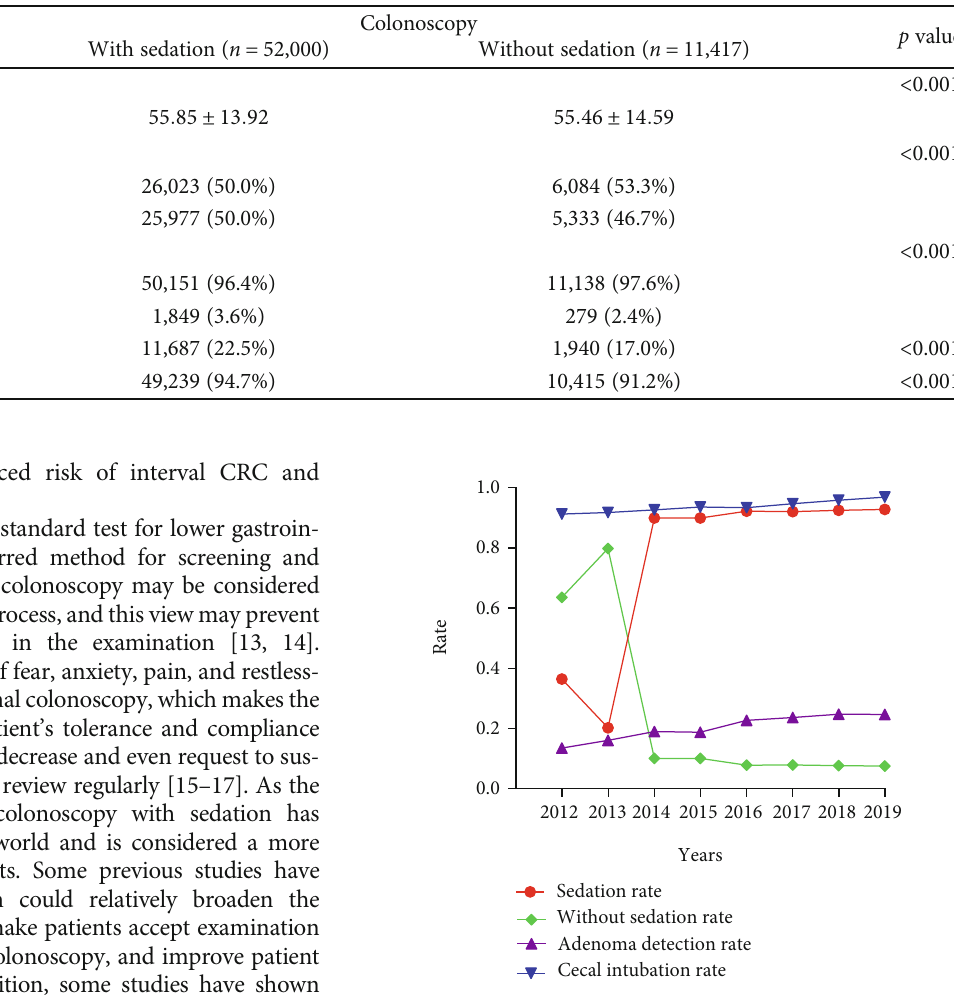
Figure 1: The rate of colonoscopy with or without sedation, adenoma detection rate, and cecal intubation rate in each year from 2012 to